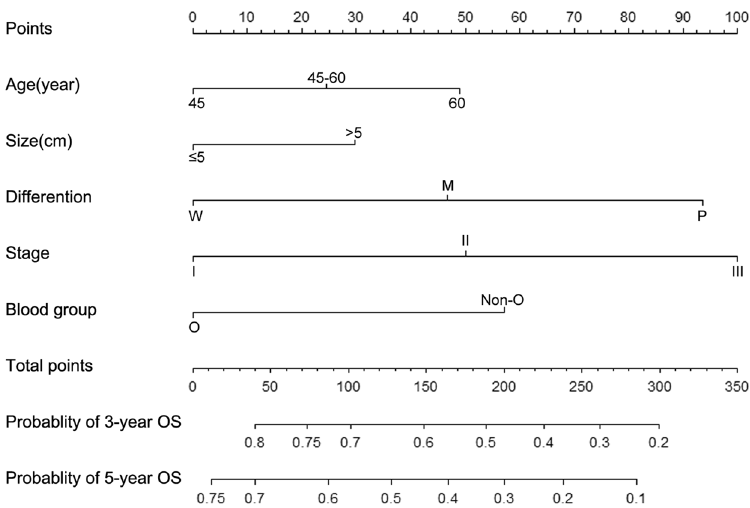
Figure 3. Nomogram predicting overall survival. Abbreviations: W, well; M, moderate; P,